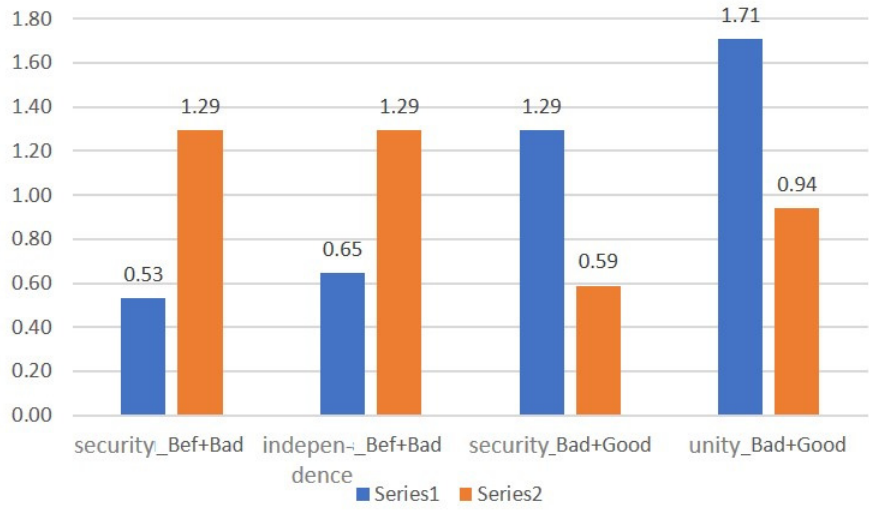
Figure 12. Comparison of the values of the scales with significant differences.